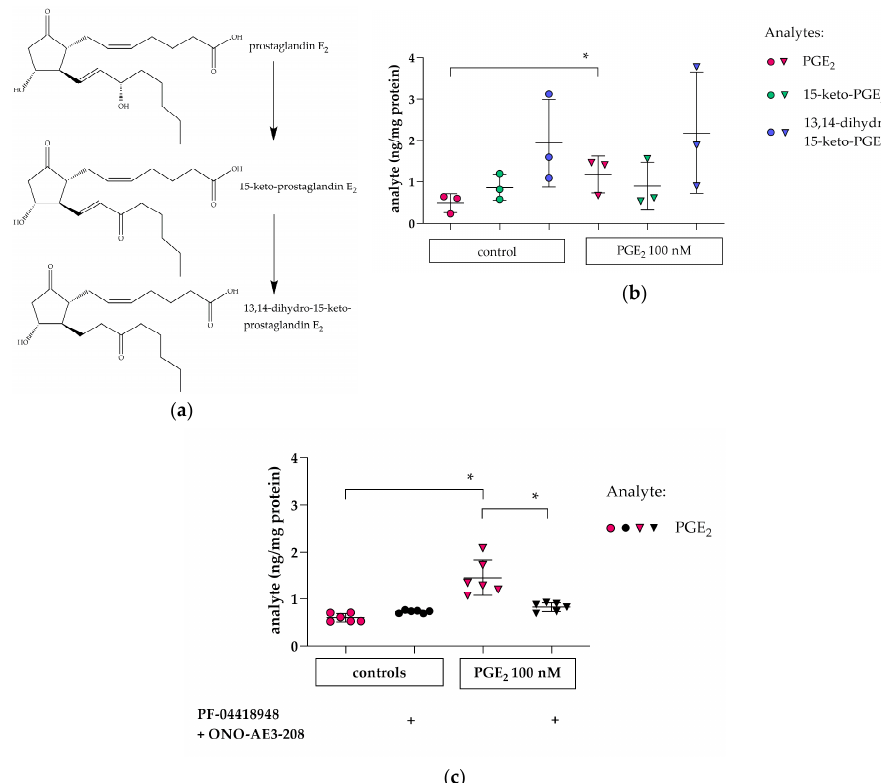
Figure 5. PGE 2 and its metabolites were measured by LC / ESI-MS / MS in hPC. ( a ) structure of PGE 2 and its metabolites; ( b ) levels of cellular PGE 2 (pink), 15-keto-PGE 2 (green), and 13,14-dihydro-15-keto-PGE 2 (blue) were measured after PGE 2 stimulation for 2 h (100 nM, triangles) and in untreated controls (circles). PGE 2 levels were increased in PGE 2 -stimulated cells (pink triangles) vs. controls (pink circles). Each datapoint represents the mean of an independent experiment (performed in triplicate on di ff erent cell passages and on di ff erent dates, each consisting of n = 3–6 replicates per treatment) and plotted as combined mean ± SD (horizontal lines). Statistics: *, p < 0.01, assessed by a two-tailed Student’s t -test in each experiment; ( c ) elevated cellular PGE 2 levels caused by PGE 2 stimulation (pink triangles) were abrogated by simultaneous co-incubation with combined EP2 and EP4 antagonism (PF-04418948 and ONO-AE3-208, respectively, 1 µ M each). + indicates addition of combined EP antagonists. Each datapoint represents a single sample and plotted as mean ± SD (horizontal lines) per treatment group consisting of n = 6 replicates obtained in a single experiment. Statistics: *, p < 0.01, assessed by a two-tailed Student’s t -test.